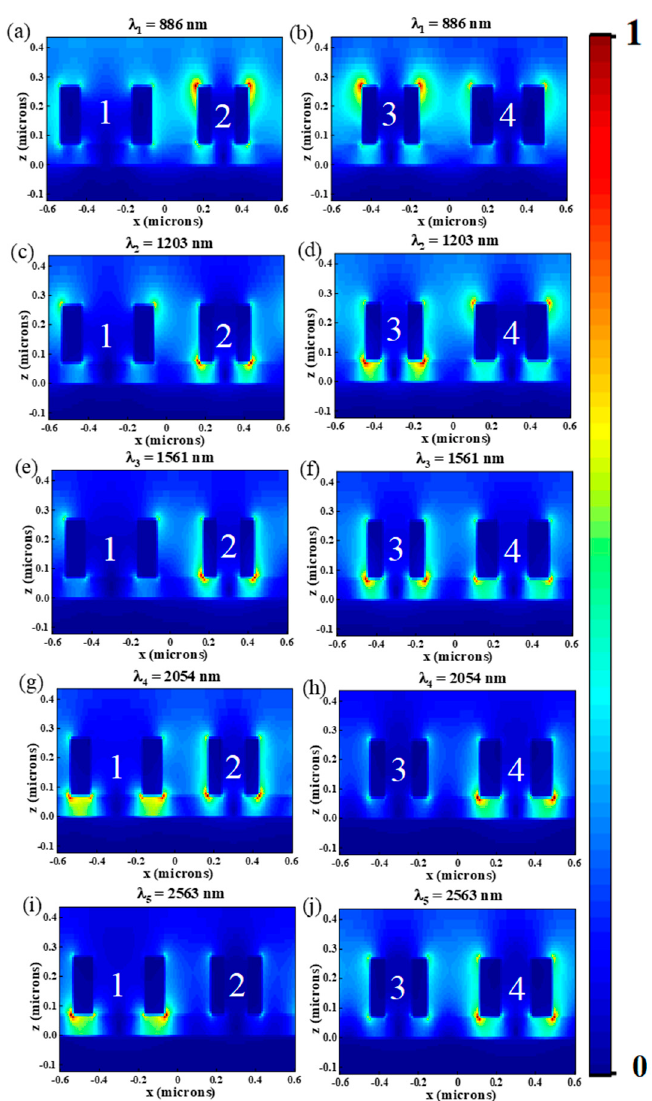
Figure 3. In the x − z plane, the electric field distribution of the absorber at ( a , b ) λ 1 = 886 nm, ( c , d ) λ 2